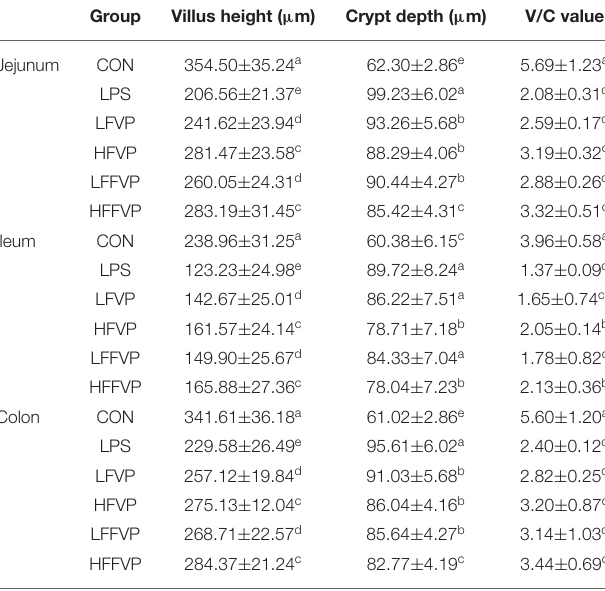
TABLE 1 | The ratio of villus height to crypt depth (V/C